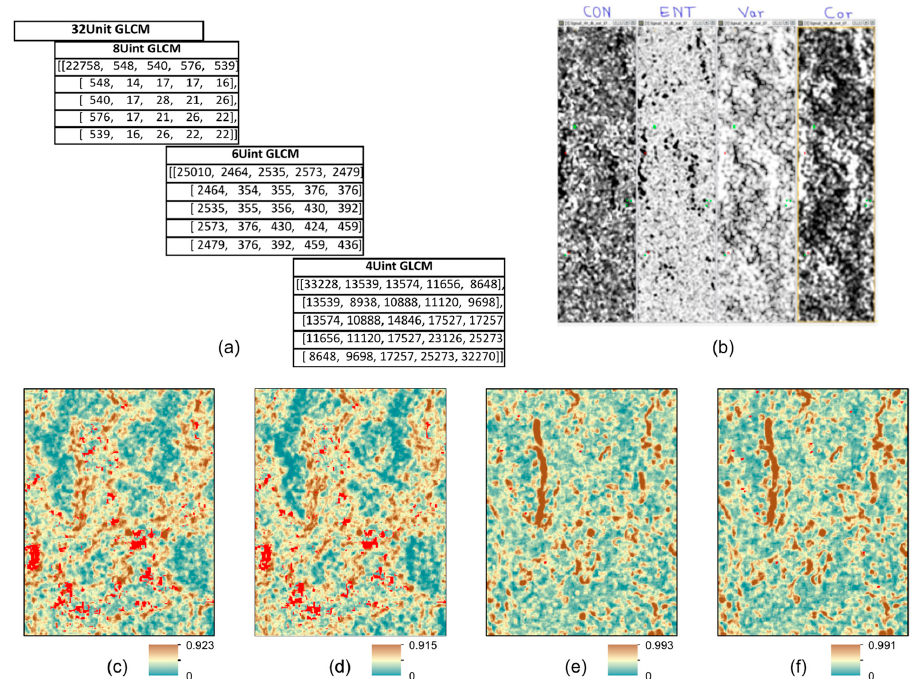
Figure 8. The classification probability maps reveal improved pixel classification at lower grey levels of quantization: ( a ) the co-occurrence values in the first 5 × 5 cells of the GLCM; ( b ) sample details of the four GLCM texture measures; and ( c – f ) snips showing the details of the classification probability map for the GL3, GL3_B8, GL3_B6, and GL3_B4 models, respectively. Unclassified areas are shown as red pixels in ( c , d Table 5. The classification results from different grey level GLCM models and land cover/land use surface area estimates. See Appendix A for details of class errors.